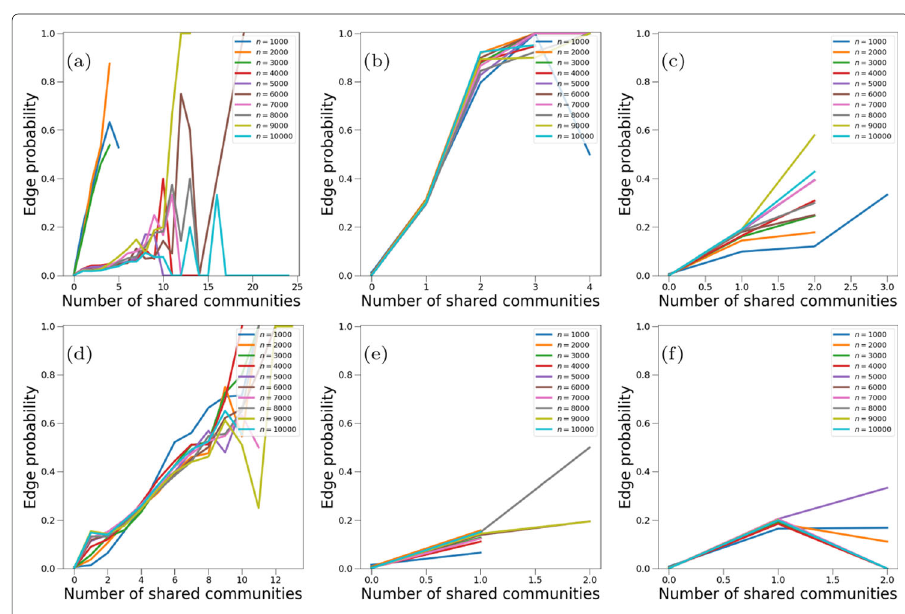
Fig. 25 Variation of the number of nodes ( n ) for LFR synthetic networks considering the edge probability: a Bigclam; b CFinder; c Copra; d Demon; e SLPA; f Ground-Truth